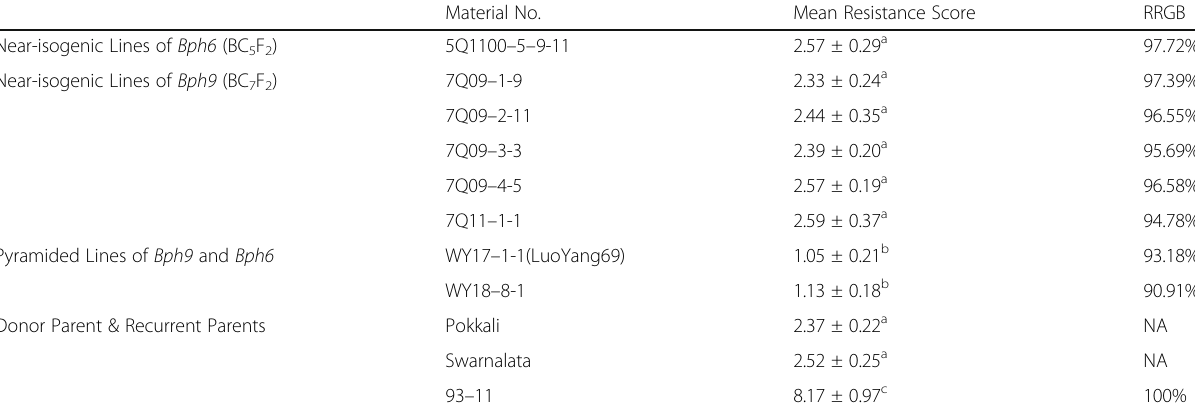
Table 1 BPH-resistance scores and 93 – 11 background recovery rate of NIL- Bph6 , NIL- Bph9 and pyramided line LuoYang69 Material No.